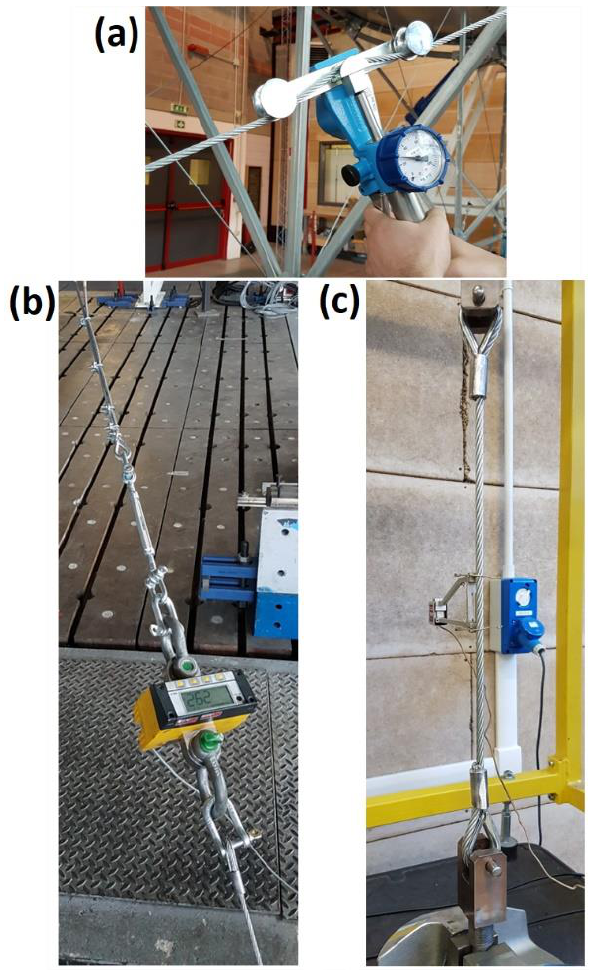
Figure 20. Measurement using the tensiometer ( a ), set-up for testing the perturbation effect of the tensiometer ( b ), experimental set-up of the tension test of the guy-wires ( c ).